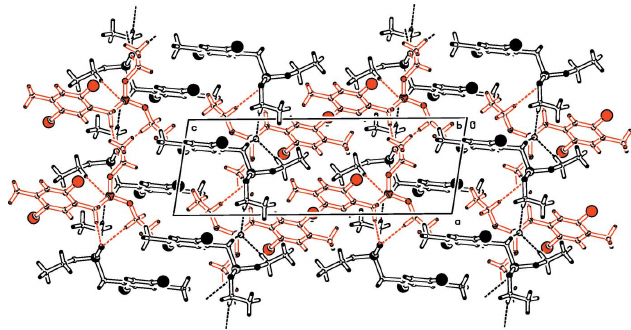
Figure 2 Part of the packing diagram. View along the b axis. Hydrogen bonds are drawn with dashed lines. The two independent molecules are drawn in different colours.